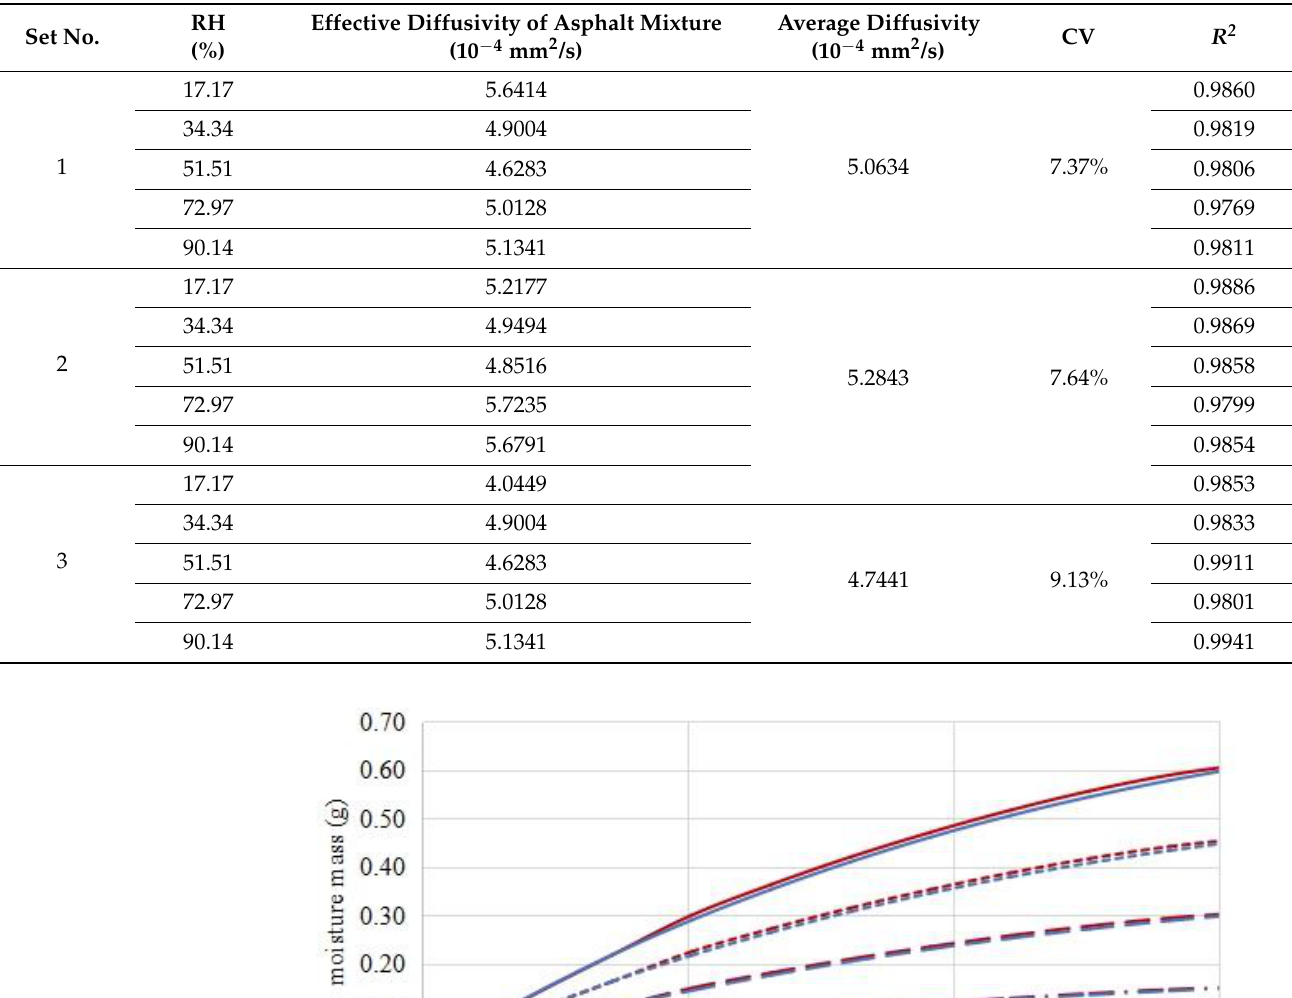
Table 11. Water vapour diffusion parameters of the asphalt mixture.